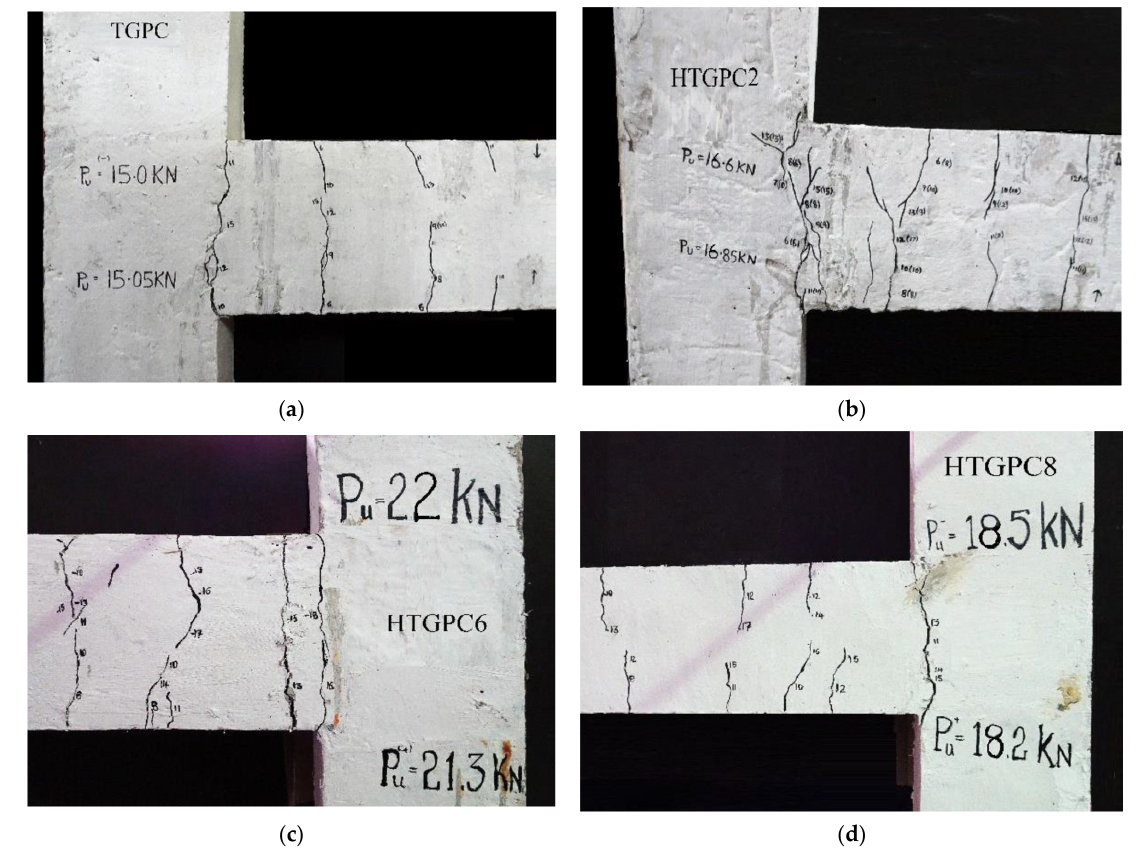
Figure 8. Typical crack patterns of the specimens: ( a ) TGPC, ( b ) HTGPC2, ( c ) HTGPC6 and ( d ) HTGPC8. Table 3. Test results for beam-column joints.